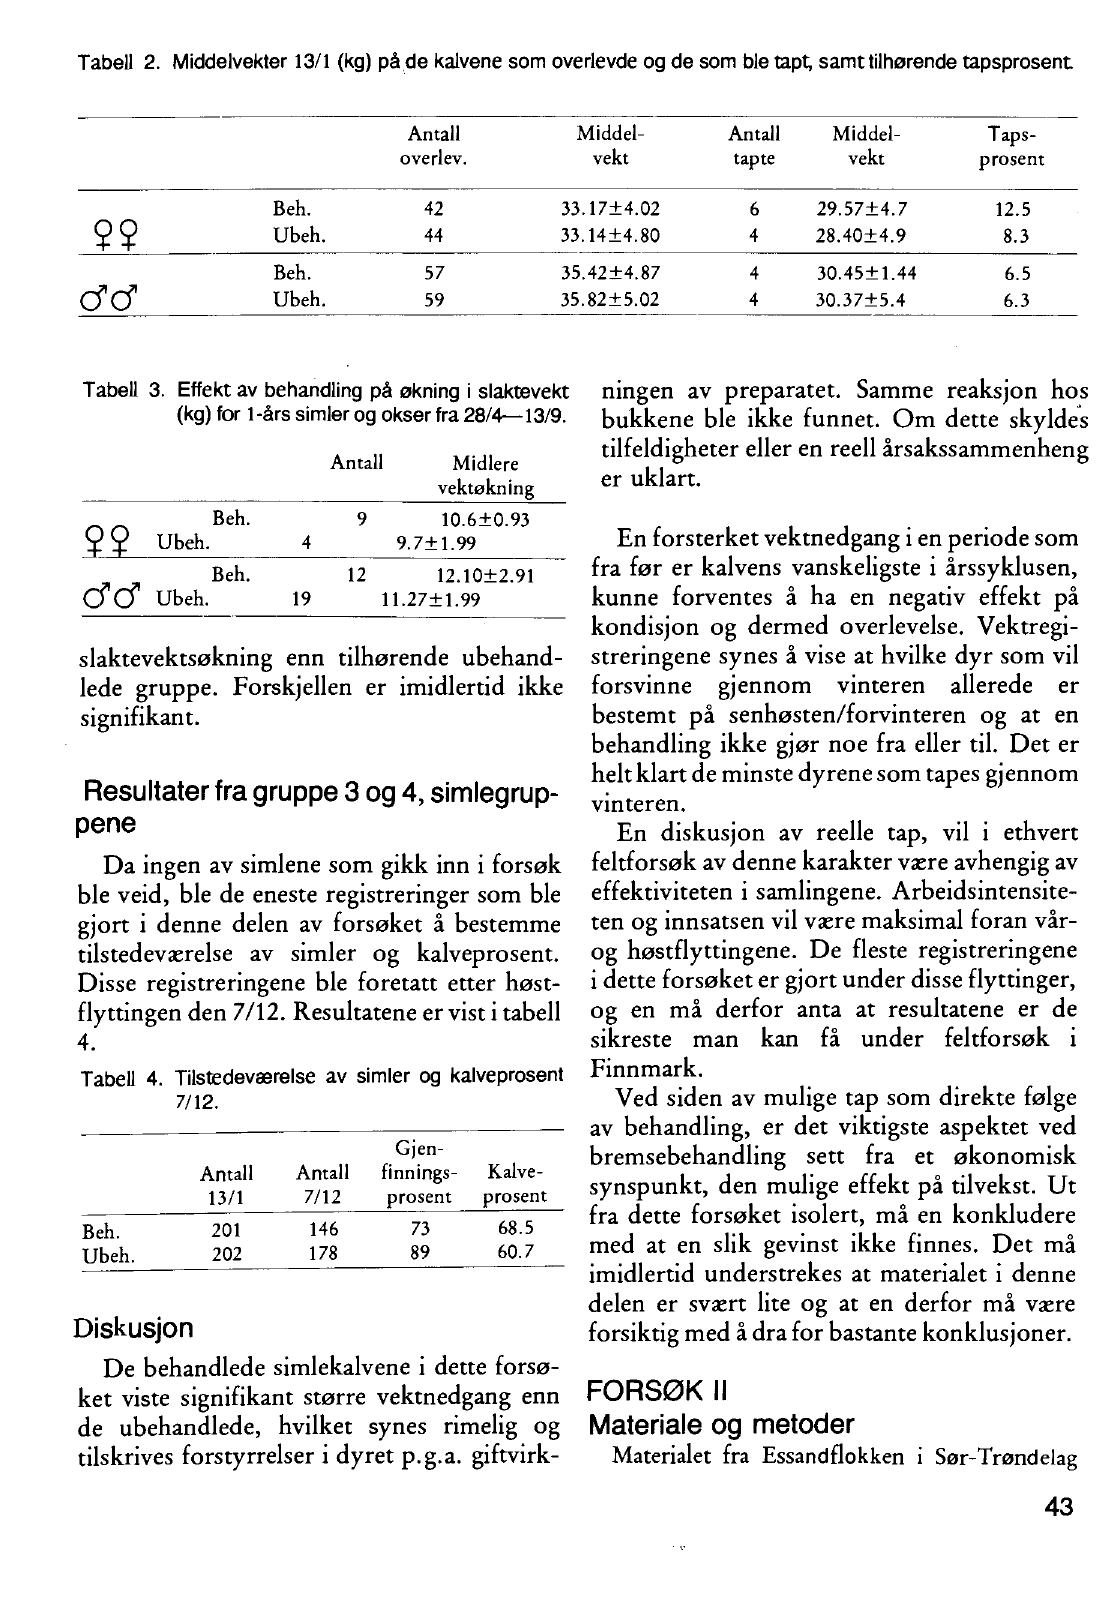
Tabell 2. Middelvekter 13/1 (kg) på de kalvene som overlevde og de som ble tapt, samt tilhørende tapsprosent.